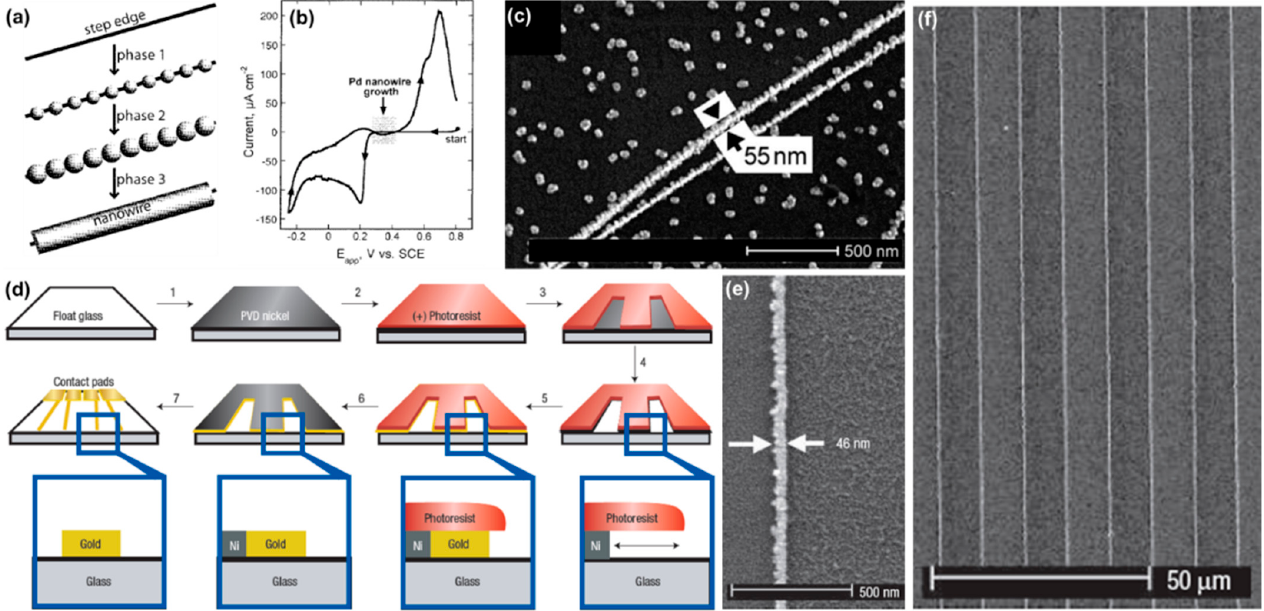
Figure 8. Electrochemical deposition on patterned planar electrodes. ( a − c ) Step edge decoration. ( a ) Schematic description of the three phases. ( b ) Cyclic voltammogram of a graphite electrode in aqueous Pd solution (2.0 mM Pd 2+ , 0.10 M HCl). The potential range used for the growth of Pd nanowires